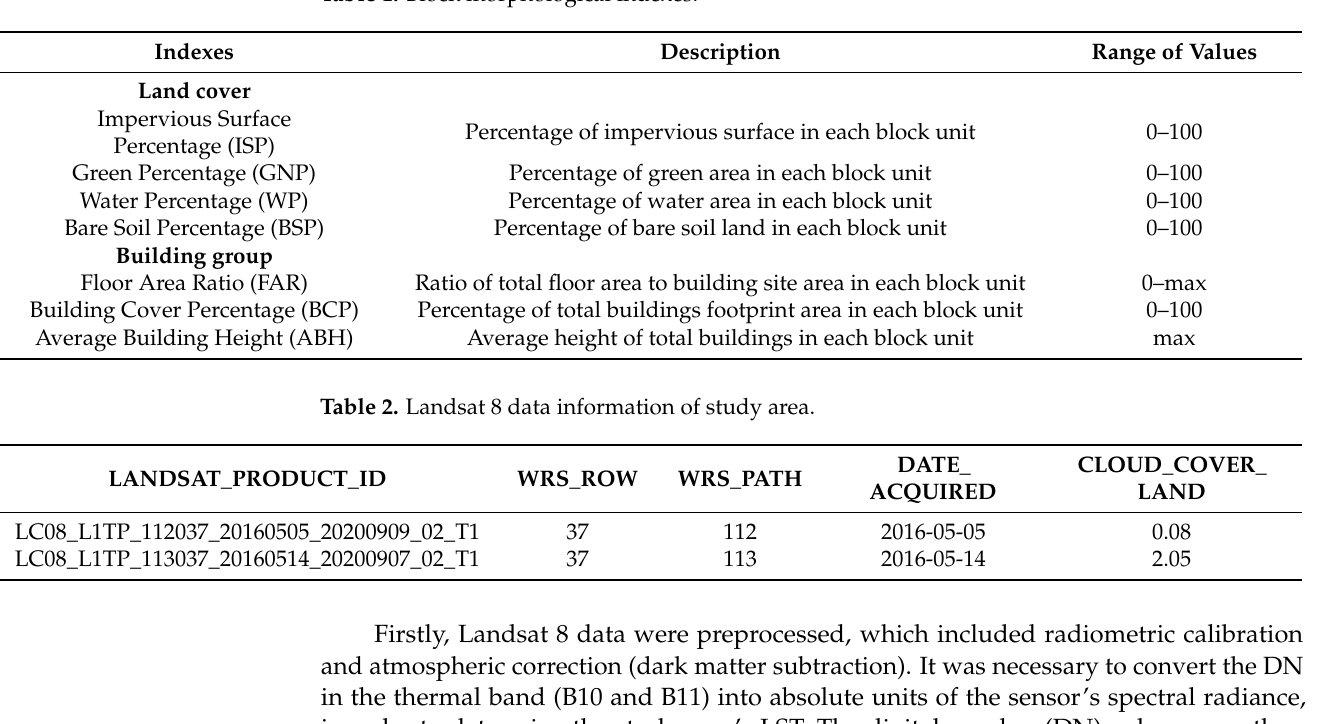
Table 1. Block morphological indexes.